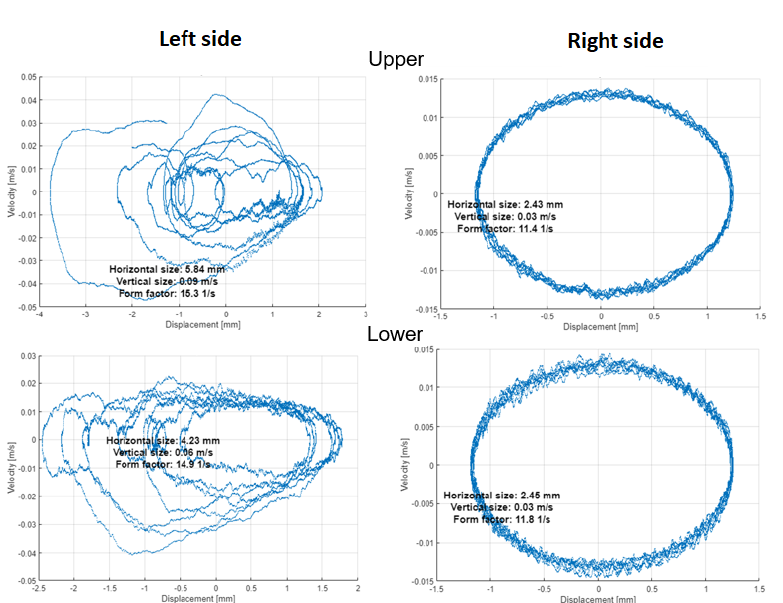
Figure 16. Phase space plots (PSP) before repair.